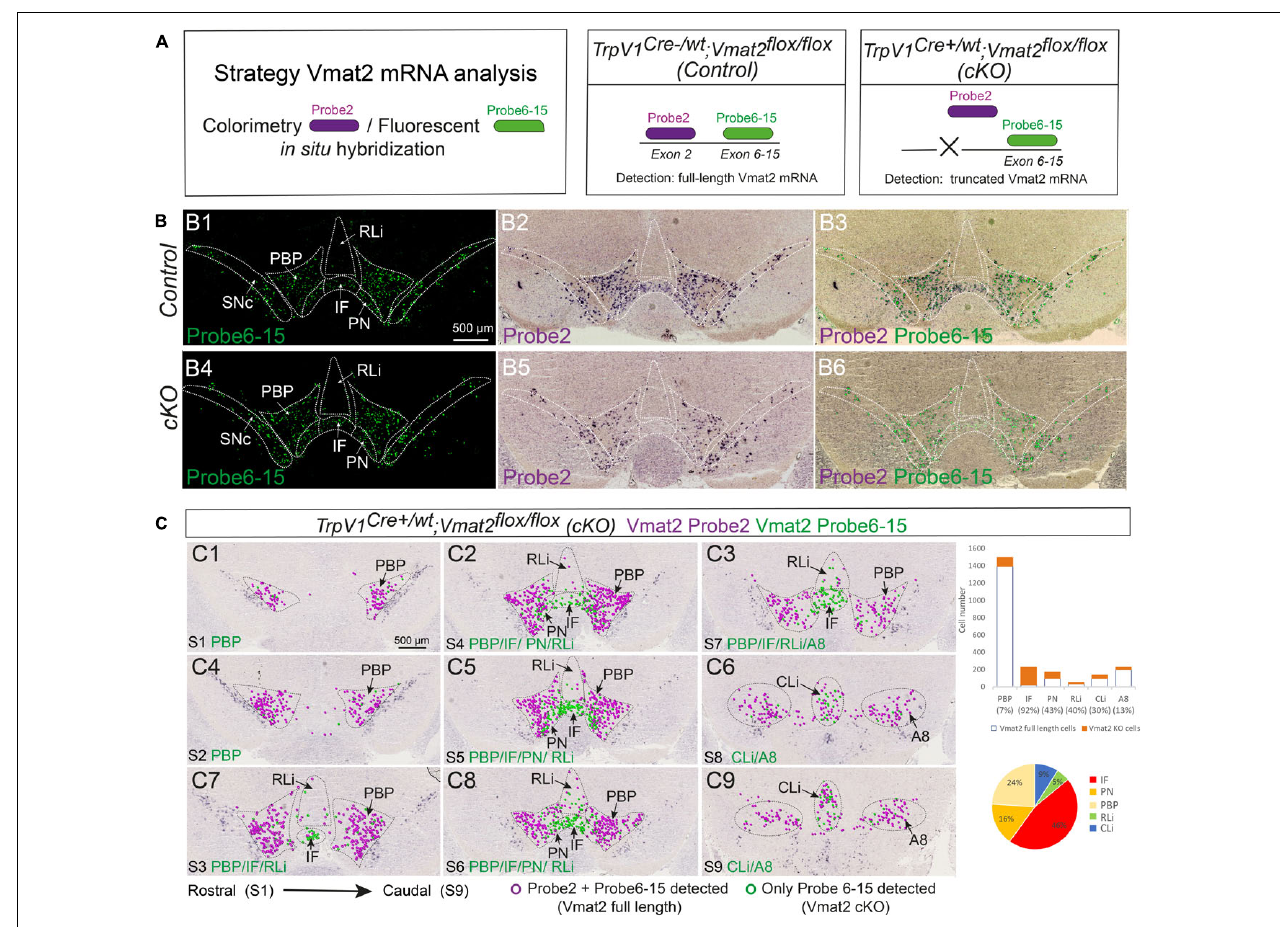
FIGURE 5 | TrpV1 Cre + / wt ;Vmat2 flox / flox cKO mice show substantial deletion of full-length Vmat2 mRNA in the medial VTA. Analysis of age-matched TrpV1 Cre − / wt ;Vmat2 flox / flox control and TrpV1 Cre + / wt ;Vmat2 flox / flox cKO adult mice (12 weeks old). (A) Schematic illustration of the Vmat2-two-probe approach